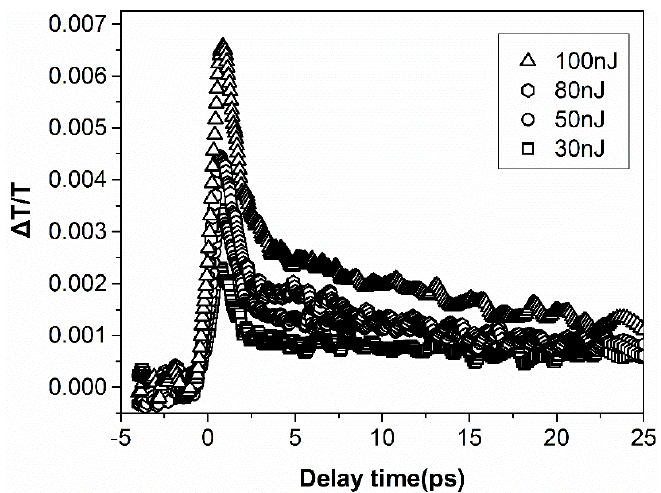
Figure 4. Transient differential transmissions Δ T/T determined at the pump energies of 100, 80, 50, and 30 nJ.